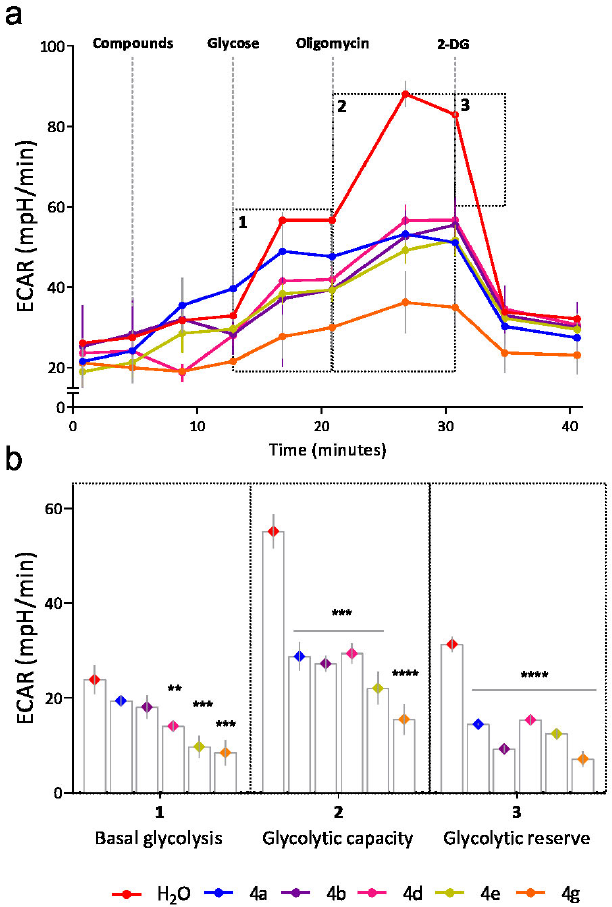
Figure 8. The influence of the studied compounds on ( a ) the glycolytic profile of tumor origin cells SH-SY5Y (neuroblastoma) and ( b ) parameters of glycolytic function. The extracellular acidification rate (ECAR) is a glycolysis indicator and shows the degree of extracellular environment acidification. The concentration of the studied compounds was 100 µ M, glucose was 10 mM, oligomycin was 1 µ M, and 2-fluoro-2-deoxy-D-glucose was 25 mM. Data are presented as mean ± error of the mean (n = 3). ** p ≤ 0.01, *** p ≤ 0.001, **** p ≤ 0.0001 compared to control (one-way ANOVA).